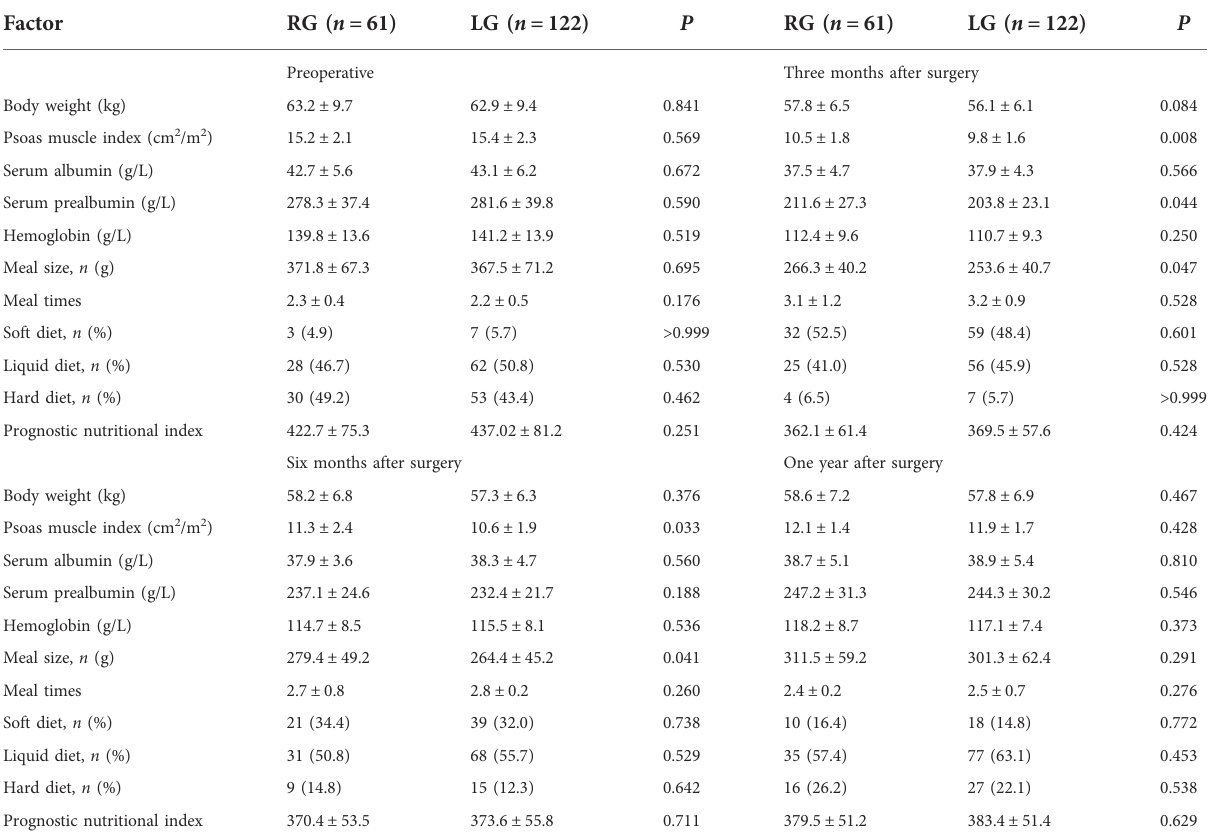
TABLE 6 Postoperative recovery of nutrition-related indicators in two groups. Factor RG ( n = 61)